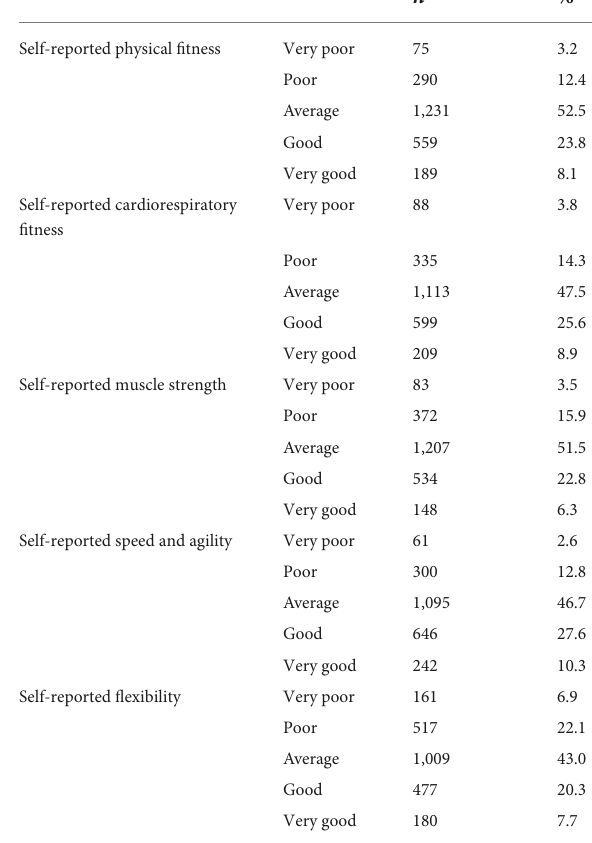
TABLE 2 The proportion of different categories of self-reported physical